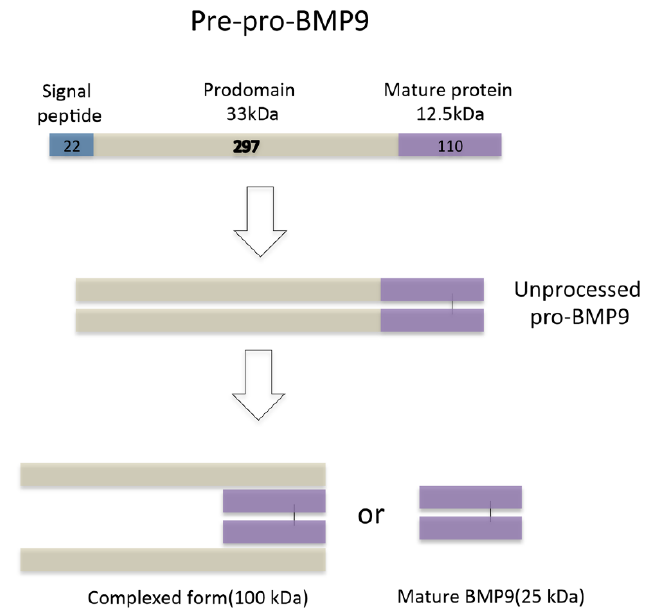
Figure 1. Bone morphogenetic protein 9 (BMP9) biosynthesis. BMP9 is synthesized as a 429 amino acids (aa) precursor protein (Pre-pro-BMP9) composed of a 22 aa signal peptide, a 297 aa prodomain and a 110 aa mature protein. The pre-pro-BMP9 then homodimerizes and is subsequently cleaved to generates two active forms: The short mature BMP9 (25 kDa) and the complexed form (100